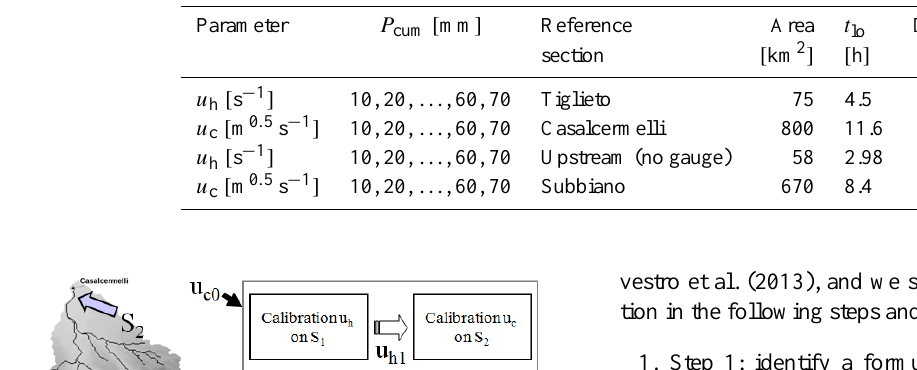
Table 3. Characteristics of the synthetic rainfall events used for the estimation of the two surface parameters in the R. S. approach. The event length is set depending on the considered basins and sections. Sections with smaller upstream drainage area are used to estimate u h while sections with larger area to estimate u c .